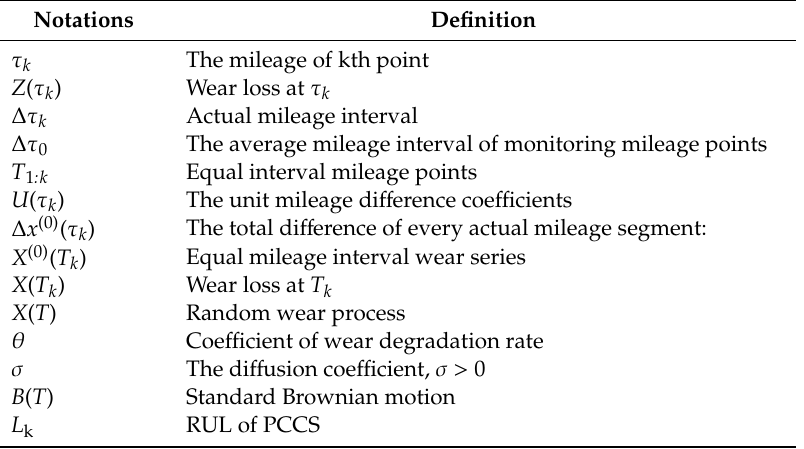
Table A1. The selected wear data of